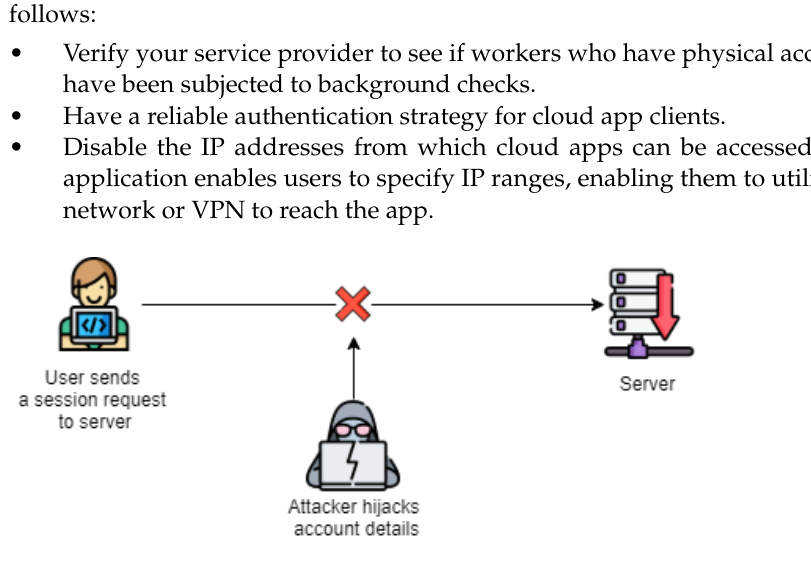
Figure 7. Graphical Representation of an account hijacking attack